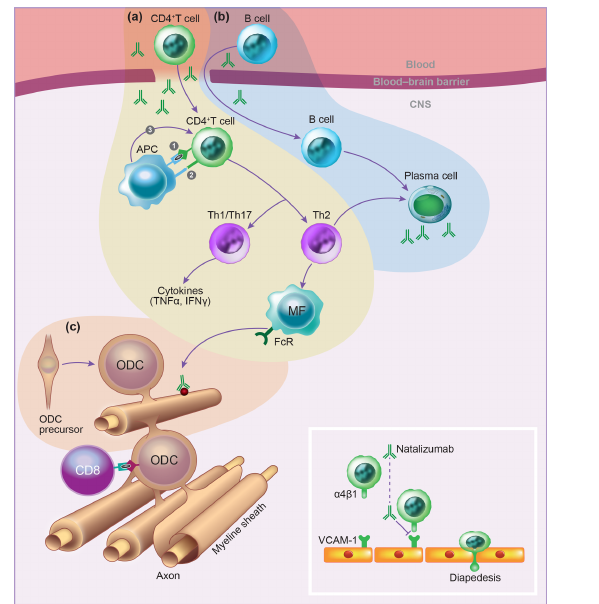
Figure 16. Schematic overview of immune processes in the EAE model. (a) Autoreactive CD4 + T cells that have been activated in peripheral lymphoid organs by the injection of antigen-adjuvant emulsion infiltrate the CNS via passage through the blood–brain barrier. This passage is mediated by interaction adhesion molecules, such as the α 4 β 1-integrin VLA-4 with ICAM-1 on blood–brain barrier endothelial cells (see insert). By local cognate interac- tions with local antigen-presenting cells, including dendritic cells, macrophages and microglia, the T cells elicit a cascade of patho- physiological reactions leading to inflammation and demyelination. (b) A second infiltrating lymphocyte type is the B cell, which se- crete antibodies that, via binding to myelin sheaths and oligoden- drocytes, elicit macrophage-mediated and complement-dependent cytotoxicity (ADCC and CDC, respectively). However, this classi- cal role of B cells requires adjustment, because B cells have a much more elaborate pathogenic role. (c) The target of the autoimmune process is the axon–myelin unit, which comprises axons, the en- wrapping myelin sheaths and the myelin-forming oligodendrocytes. In the healthy CNS, damaged oligodendrocytes can be replaced by infiltrating oligodendrocyte precursor cells (OPCs), but this repair capacity seems impaired in